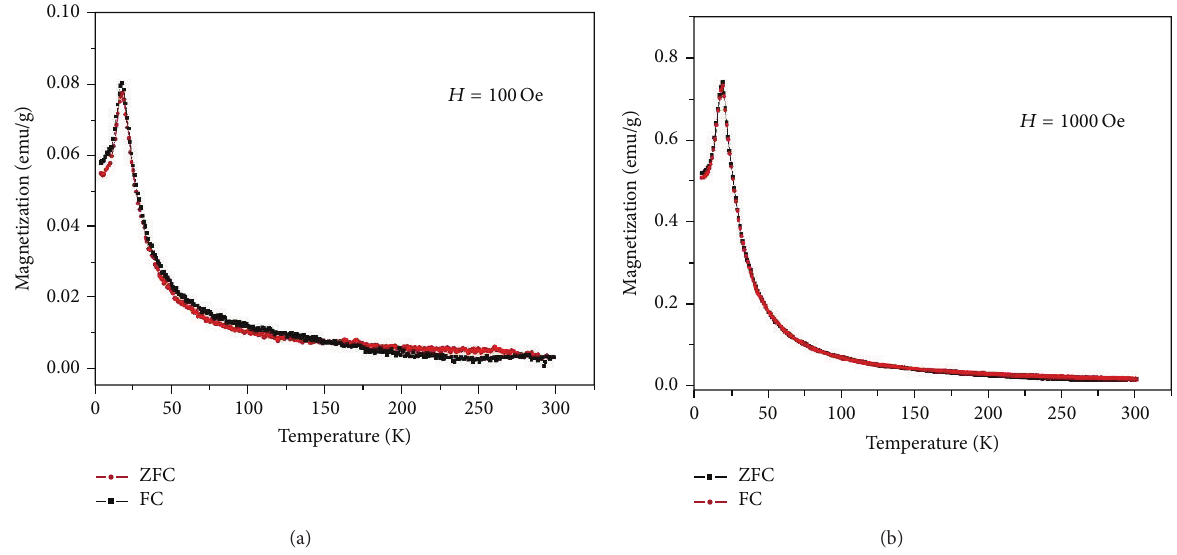
Figure 6: Temperature dependence of the ZFC and FC magnetizations for 𝛼 , 𝛽 -NiMoO 4 nanorods measured under 100Oe (a) and 1000Oe (b) applied